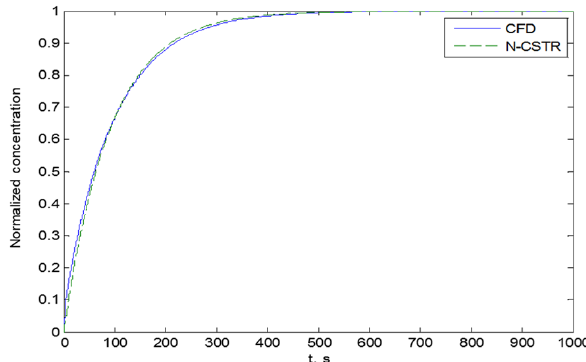
Figure 5. Comparison of F curve output between simulation (CFD) and tracer test (N-CSTR) for configuration I at 78s spacetime. N- CSTR is an acronym (describing “N” CSTRs in series) equivalent to TIS: both refer to the tank-in-series model (see Sect.